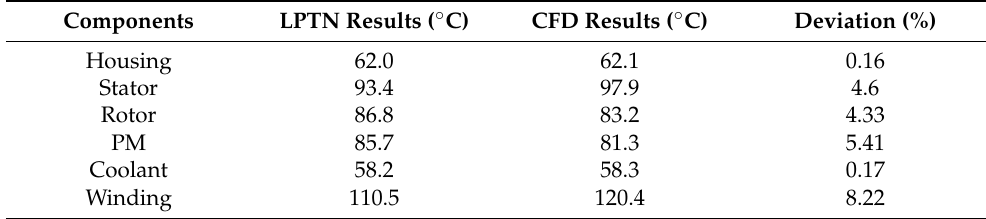
Table 5. Comparison of temperature calculation results under 1500 r/min @ 130 kW. Components